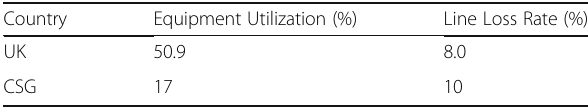
Table 8 Equipment utilization of UK and CSG in 2010 Country